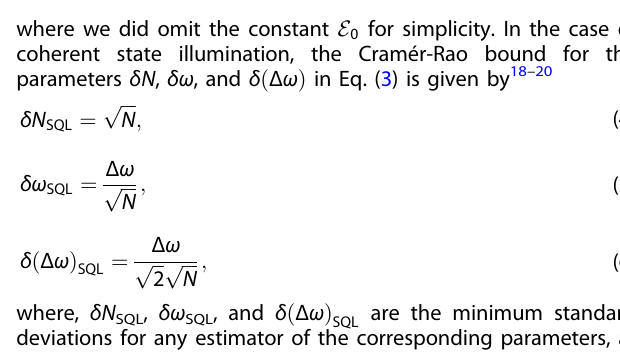
Fig. 1 Multi-parameters estimation scheme. a Parameter estimation with a multimode detection scheme. A light beam carrying the parameters is interrogated with a multi-pixel detector (MPD), and via post-processing the associated optical modes, multiple parameters can be simultaneously estimated. b Modal decomposition of a noisy optical pulse: physical noise parameters can be associated with different time/frequency modes. We represent here photon number and central frequency noise modes. Measurement of the associated modes can lead to Cramer-Rao bound limited